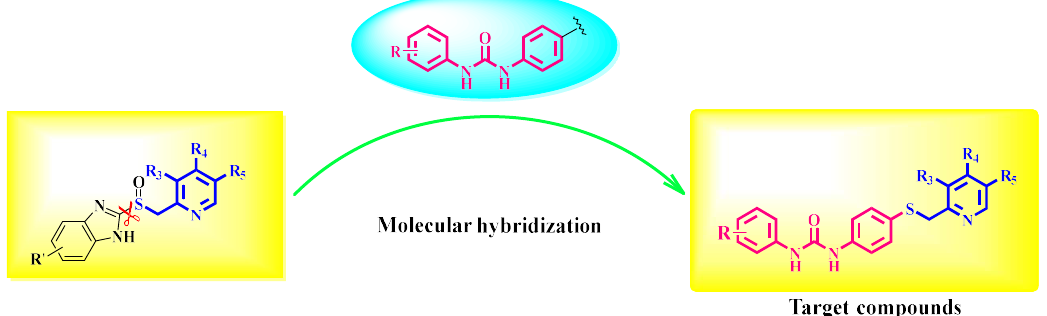
Figure 4. Rational design of the target compounds based on molecular hybridization strategy.